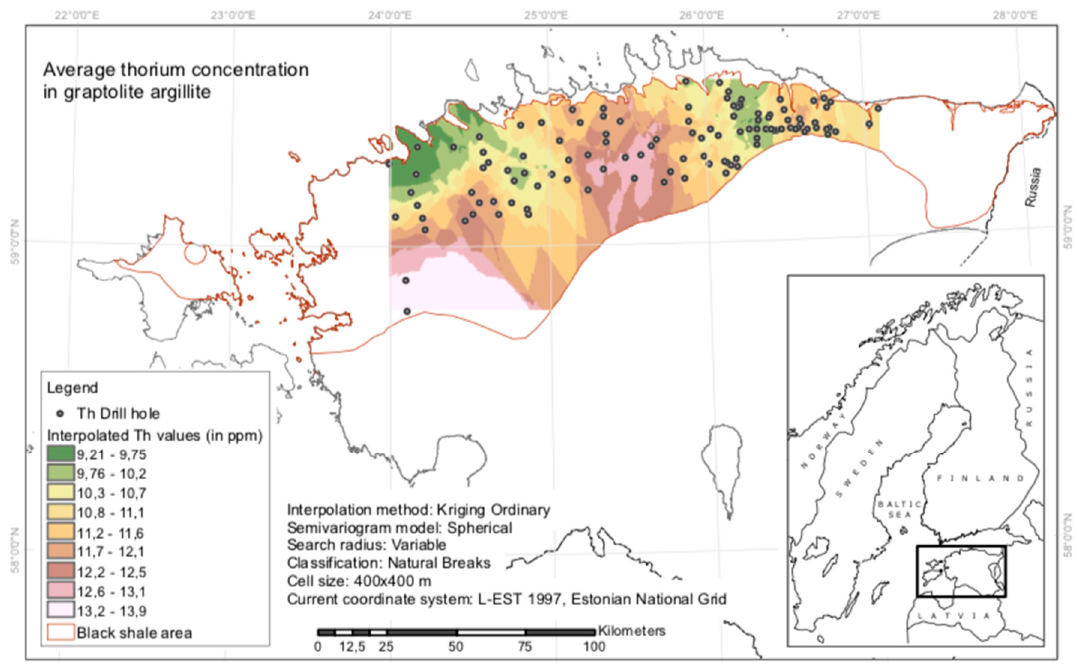
Figure 4. Location map of the drill holes with available thorium data of the graptolite argillite. The thorium distribution model was calculated using Kriging interpolation.